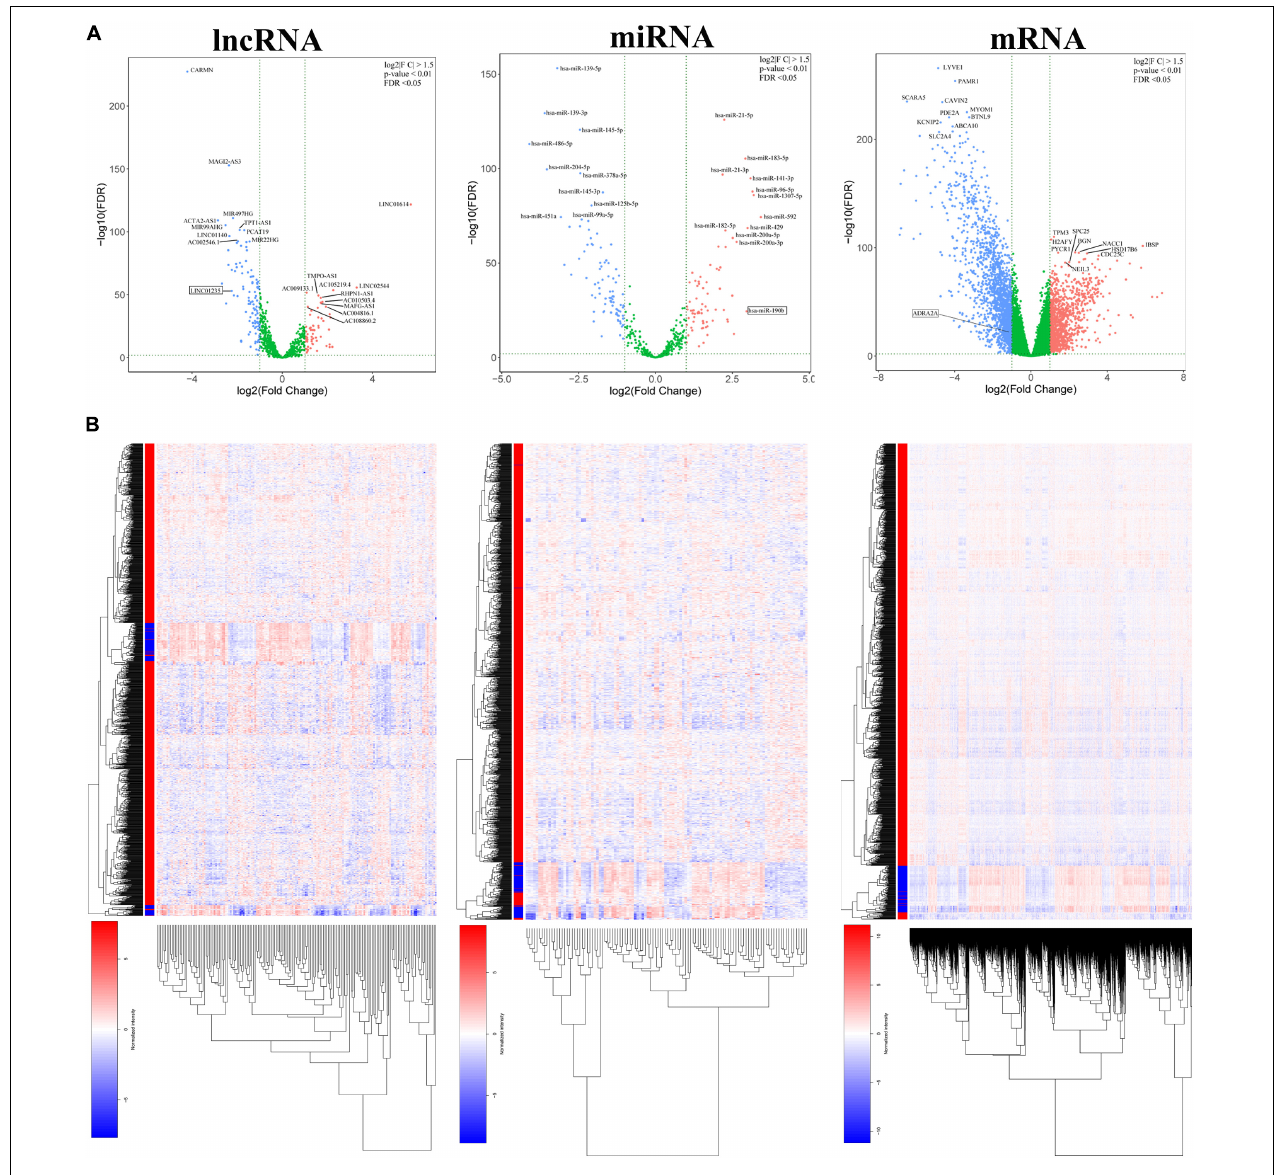
FIGURE 1 | (A) Volcano plots of differentially expressed RNAs (lncRNA, miRNA, and mRNA) in the The Cancer Genome Atlas (TCGA) database of breast cancer. The red dots represent upregulated RNAs, and the blue dots represent downregulated RNAs. The green dots represent genes with no significant difference. (B) Heatmap of differentially expressed RNAs (lncRNA, miRNA, and mRNA) in the TCGA database of breast